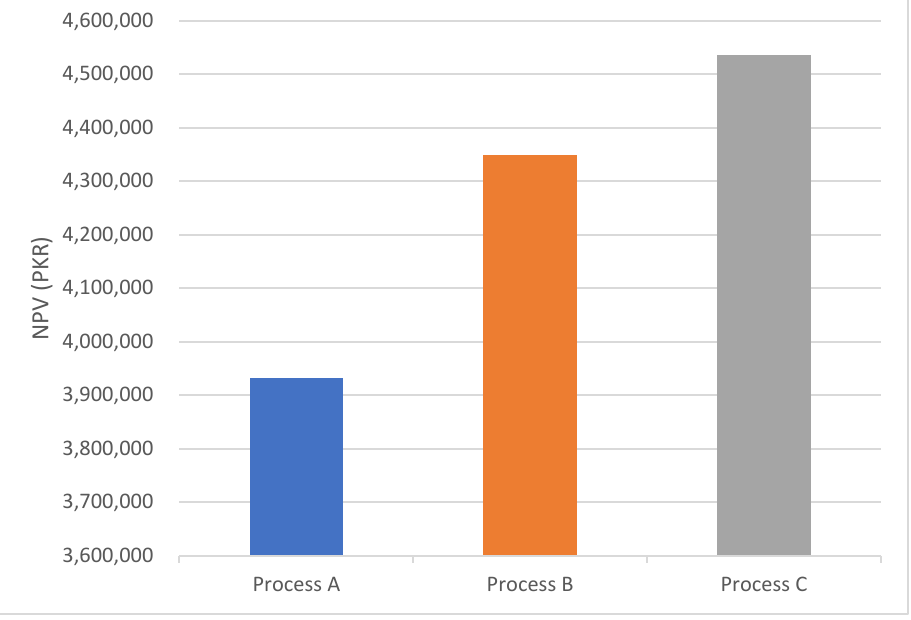
Figure 11. NPV of designed system.